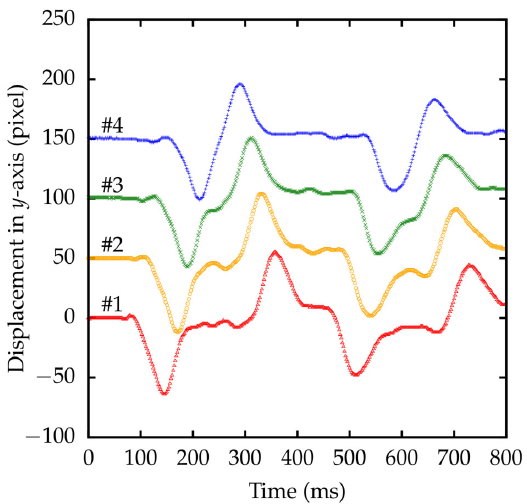
Figure 15. Measured displacement of four markers on a string. The origin of each plot is shifted for visibility. A histogram of timestamp errors between the master and slaves is shown in Figure 16. For the four-node system, the timestamp error distribution is similar to that of the binocular system shown in Figure 10. Although relatively small-scale experiments were presented here, the proposed scheme can be applied to systems of considerably larger scale.